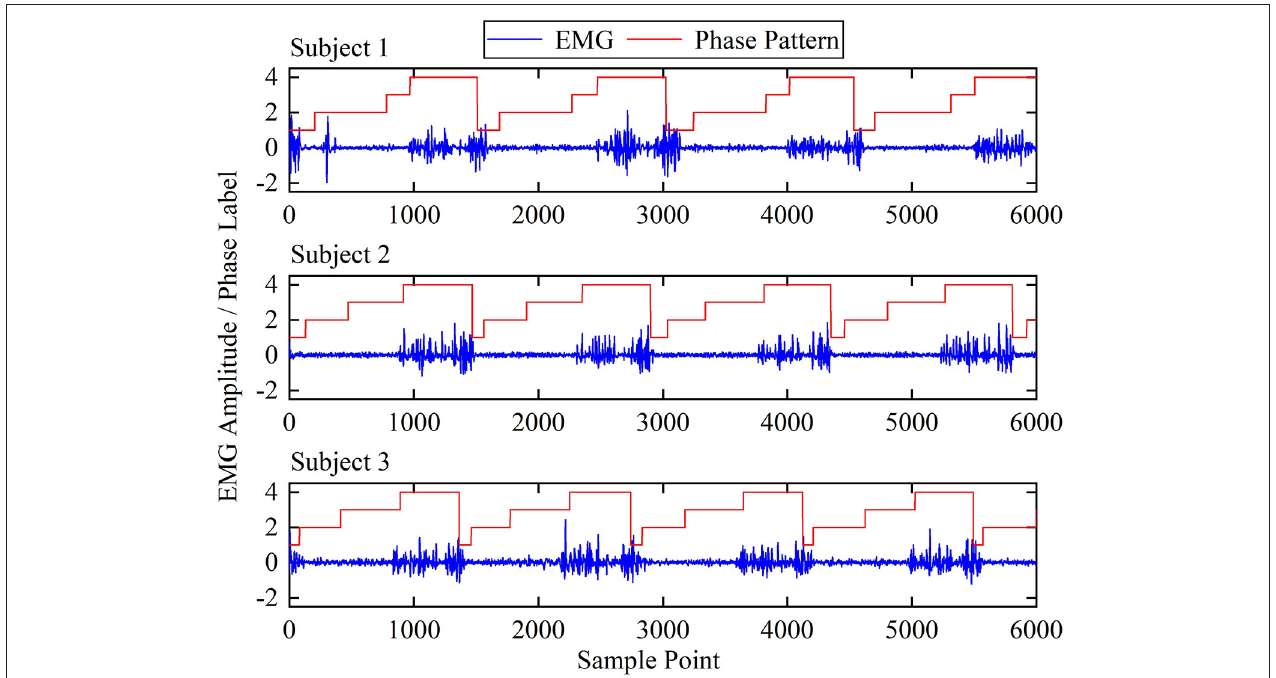
FIGURE 4 | The EMG amplitude of tibialis anterior among different